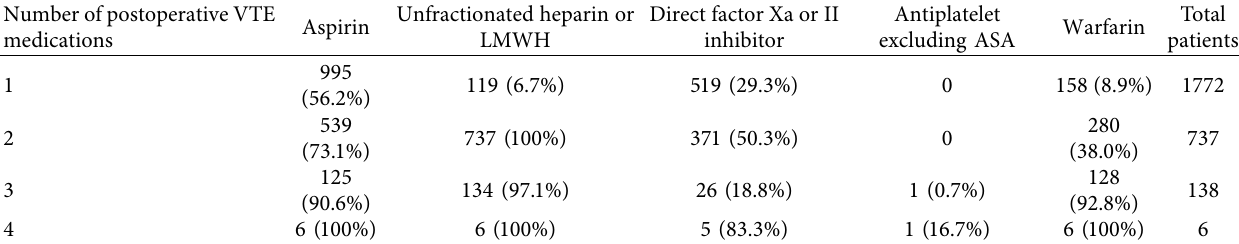
Table 1: Postoperative anticoagulants prescribed.